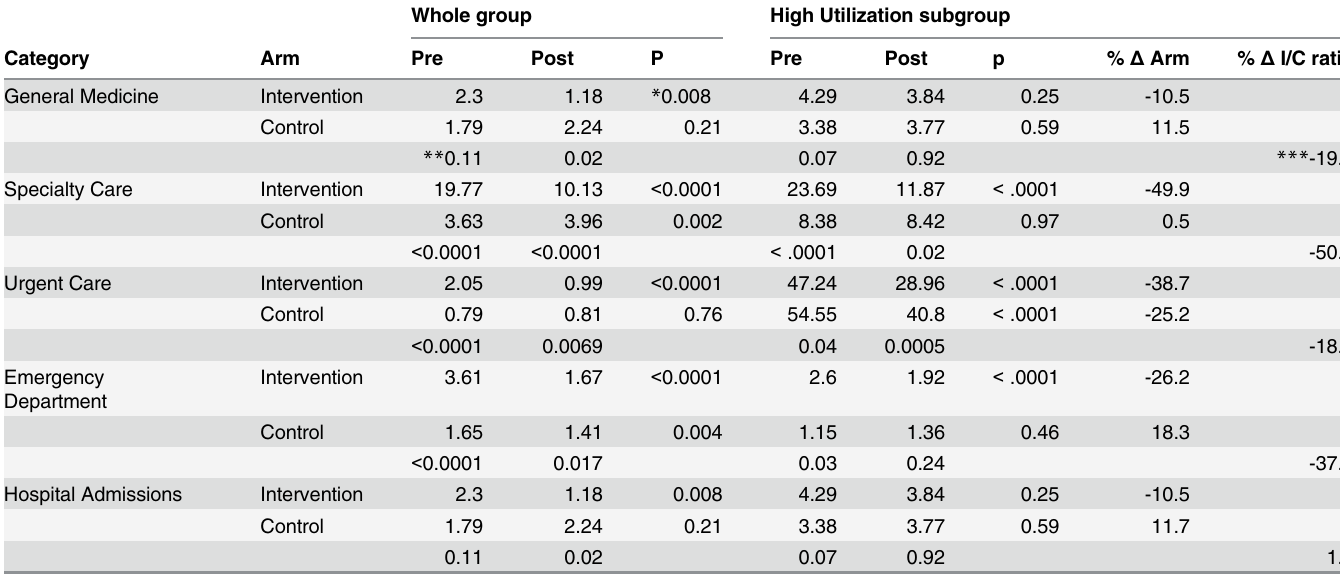
Table 4. Service Site: Utilization Rate (Pre- vs. Post — Intervention) by Average Billable Encounters/year. Whole group High Utilization subgroup Category General Medicine